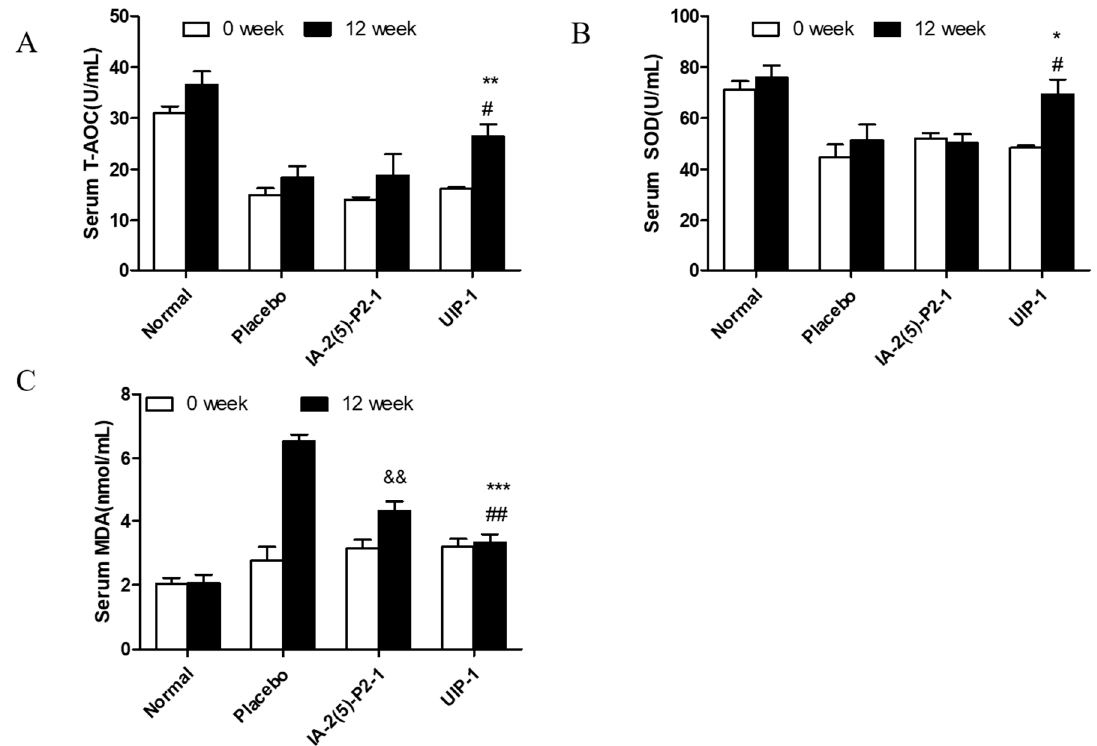
Figure 3. Effect of UIP-1 on serum SOD and T-AOC activity and MDA concentrations in the serum of mice. T-AOC ( A ), SOD ( B ) and MDA ( C ) levels in every group were determined. Data are expressed as the mean ± SEM ( n = 3). * p < 0.05, ** p < 0.01, *** p < 0.001; UIP-1 versus placebo group. # p < 0.05, ## p < 0.01; UIP-1 versus IA-2(5)-P2-1 group. && p < 0.01; IA-2(5)-P2-1 versus placebo group, one-way ANOVA.